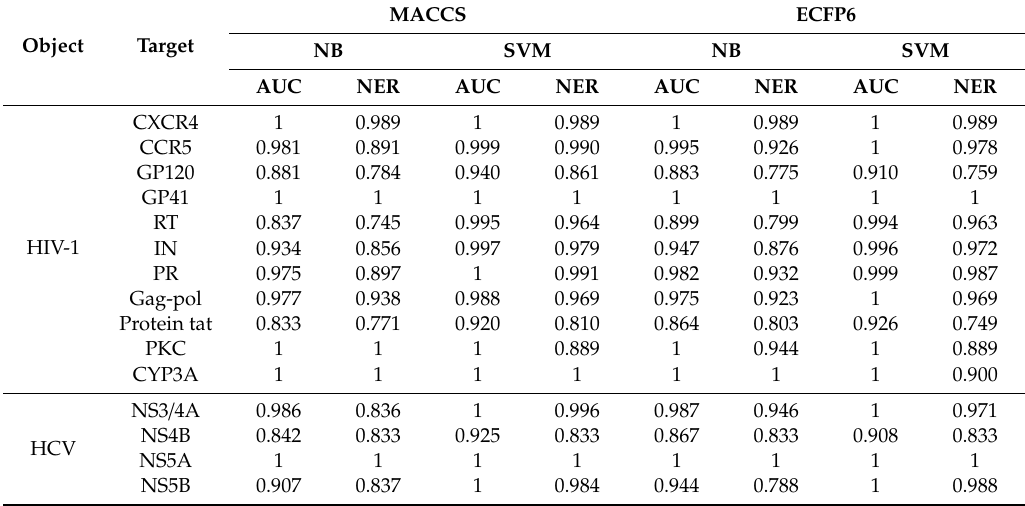
Table 3. The test results for the performance of the 60 multiple QSAR models determined by test set validation.